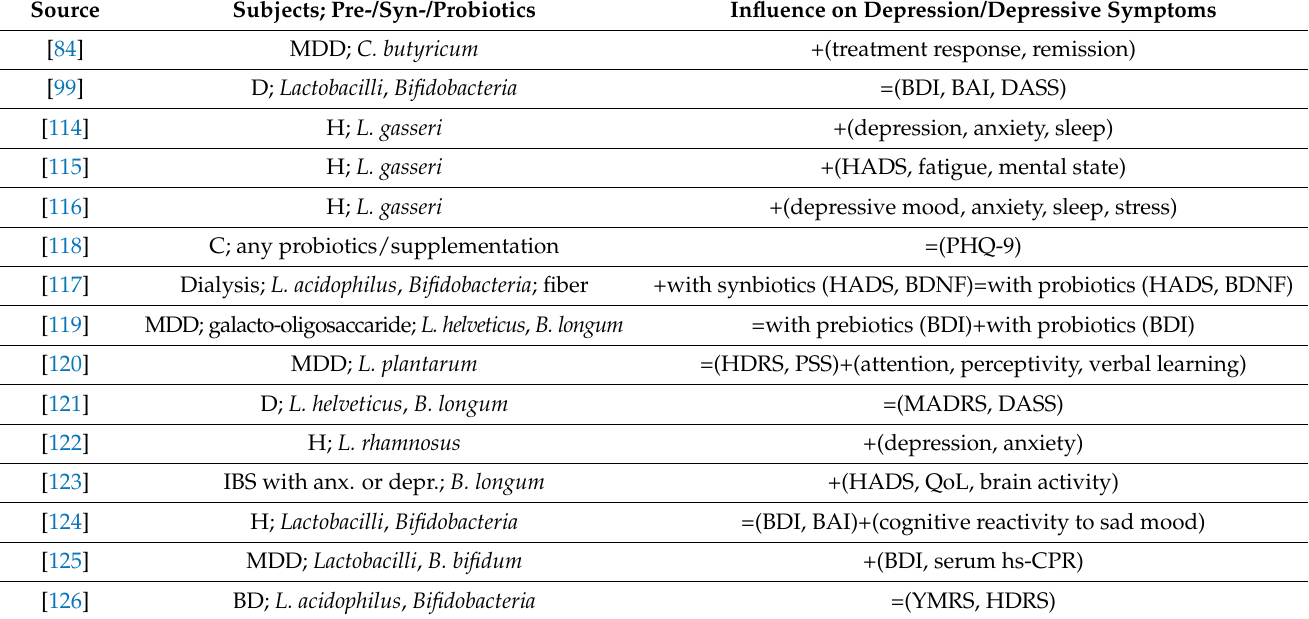
Table 7. Effect of prebiotics, probiotics, and synbiotics on